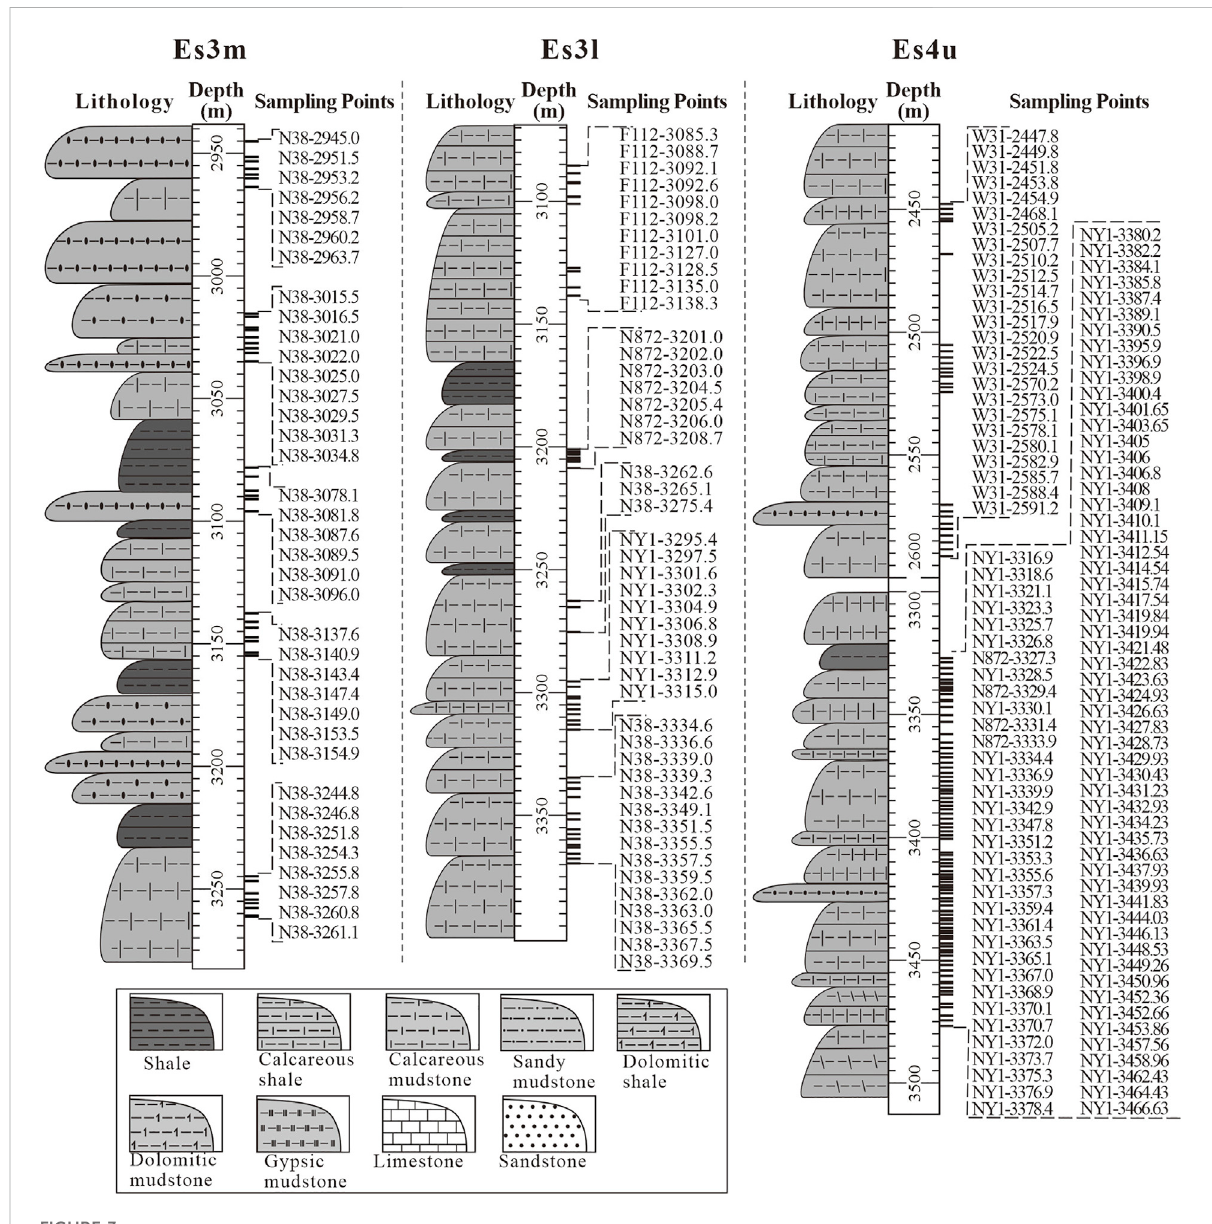
FIGURE 3 Distribution of samples in each member of the Shahejie